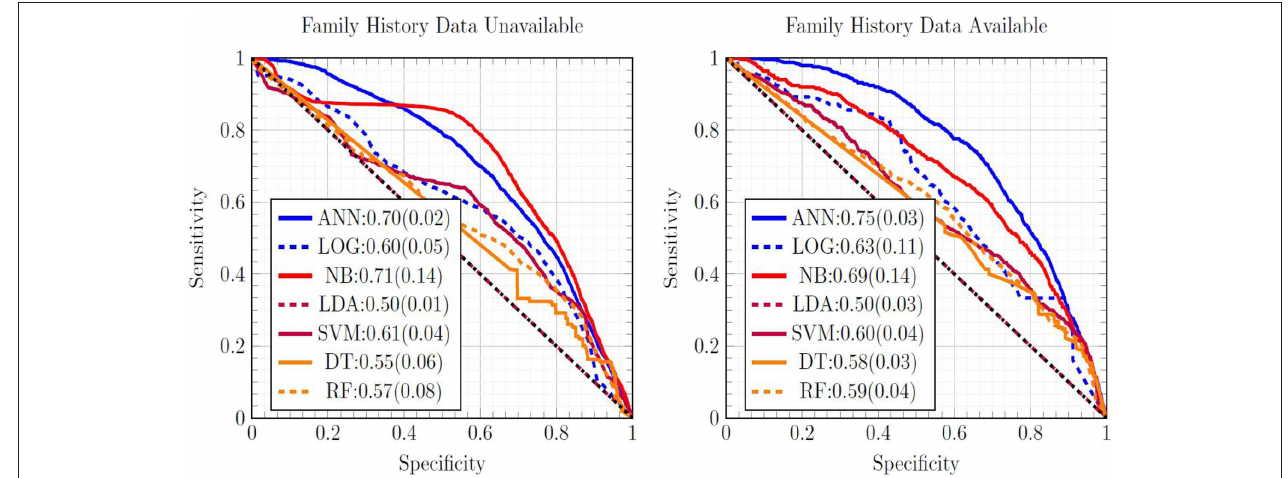
FIGURE 1 | Comparison of ROC curves of all seven MLAs, with the mean concordance and its uncertainty reported. Expectation maximization was used to impute missing data.